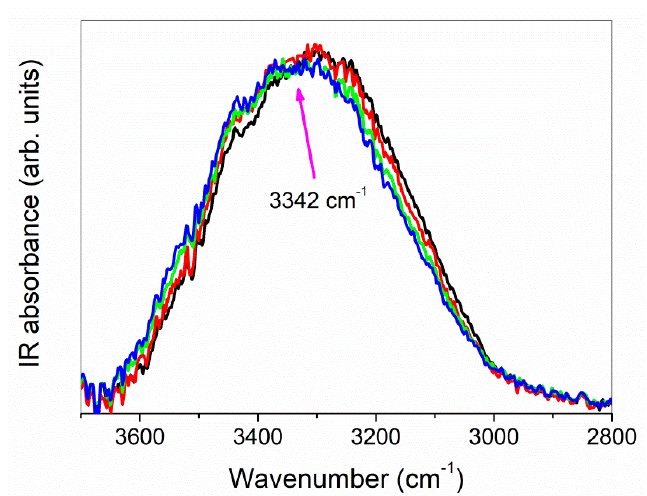
Figure 5. Experimental FTIR-ATR spectra for the IDE/HP- β -CD 1:2 inclusion complex, in the O–H stretching region, plotted vs. T at 250 K (black line), 280 K (red line), 300 K (green line), and 340 K (blue line) as examples. The isosbestic point is centered at ∼ 3342 cm − 1 .